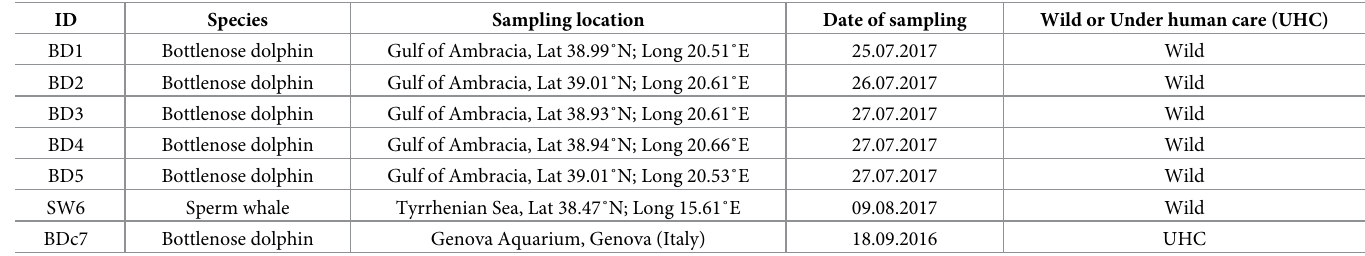
Table 1. Data of sampled